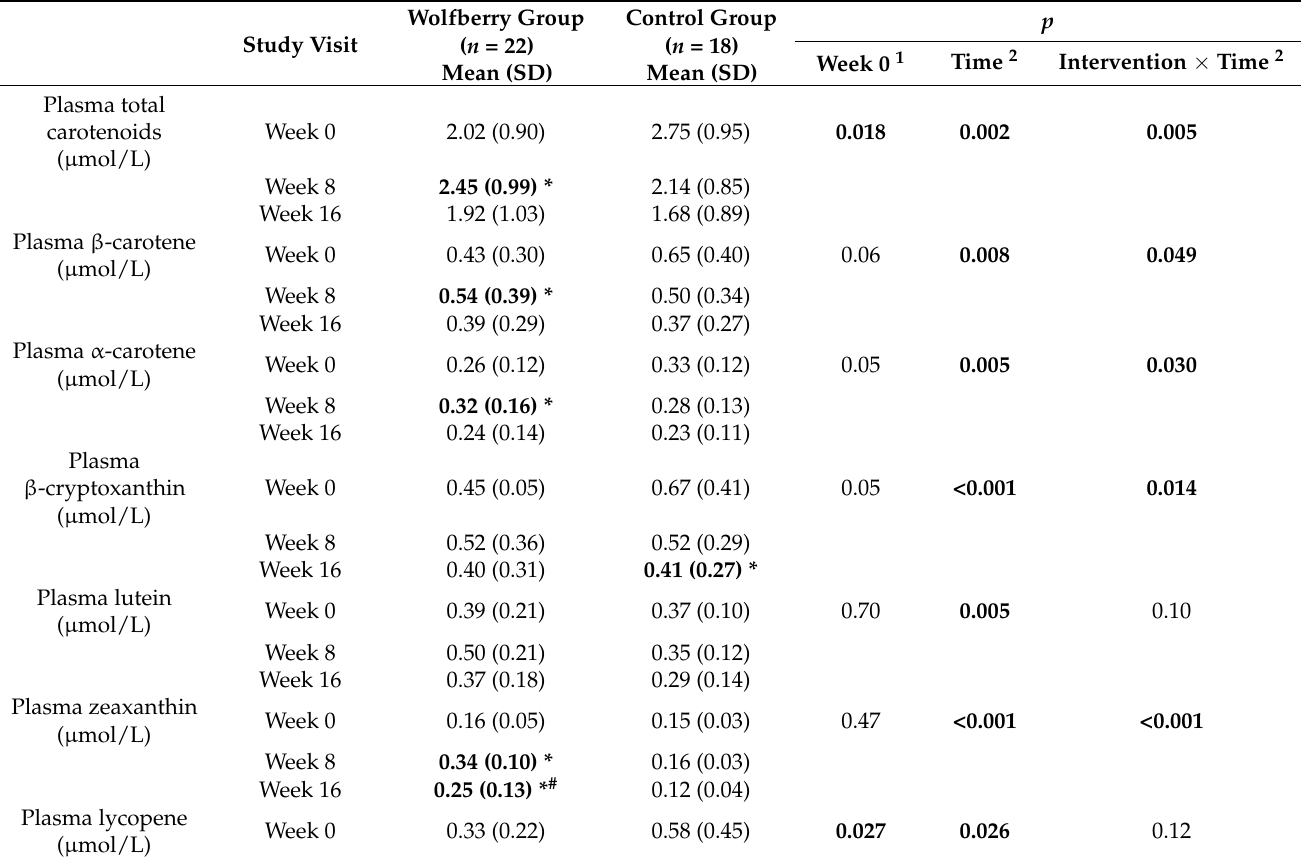
Table A1. Plasma carotenoids status at different time points in randomized controlled